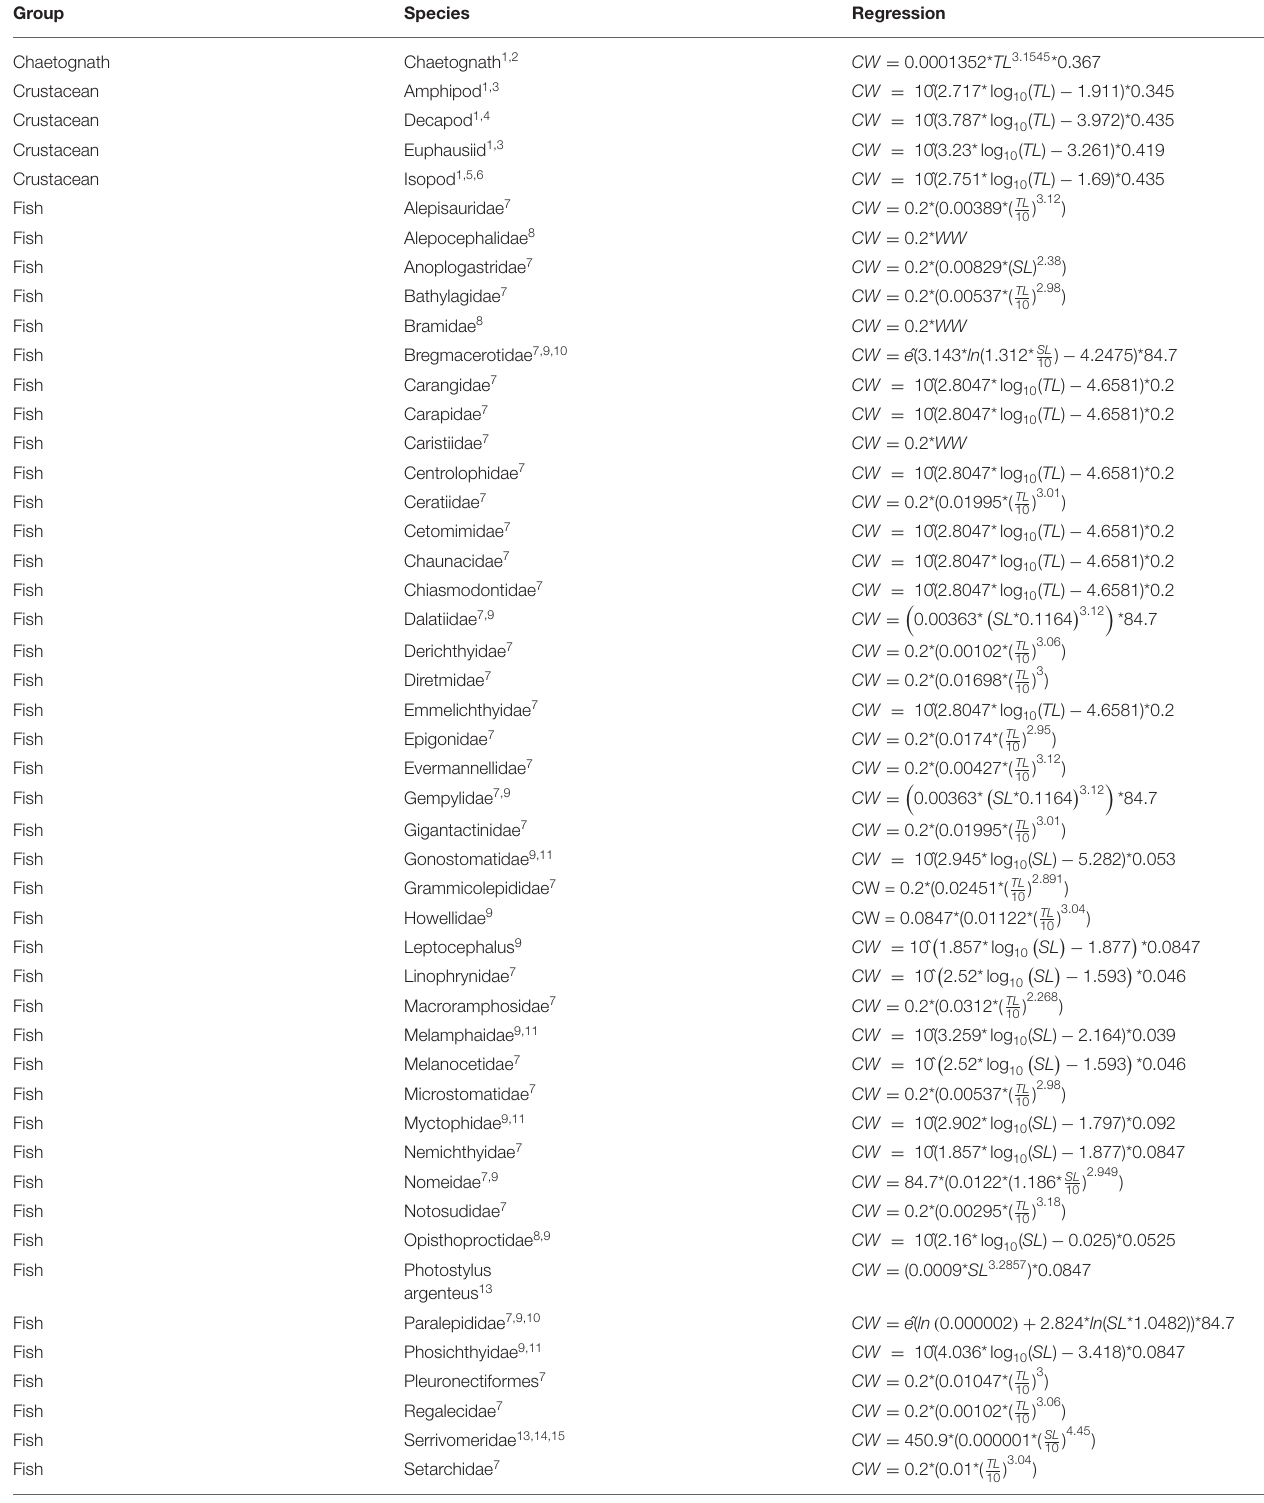
TABLE S-3 | Length to weight relationships used to calculate carbon weight (CW; in mg) for micronekton captured in the MIDOC. Group